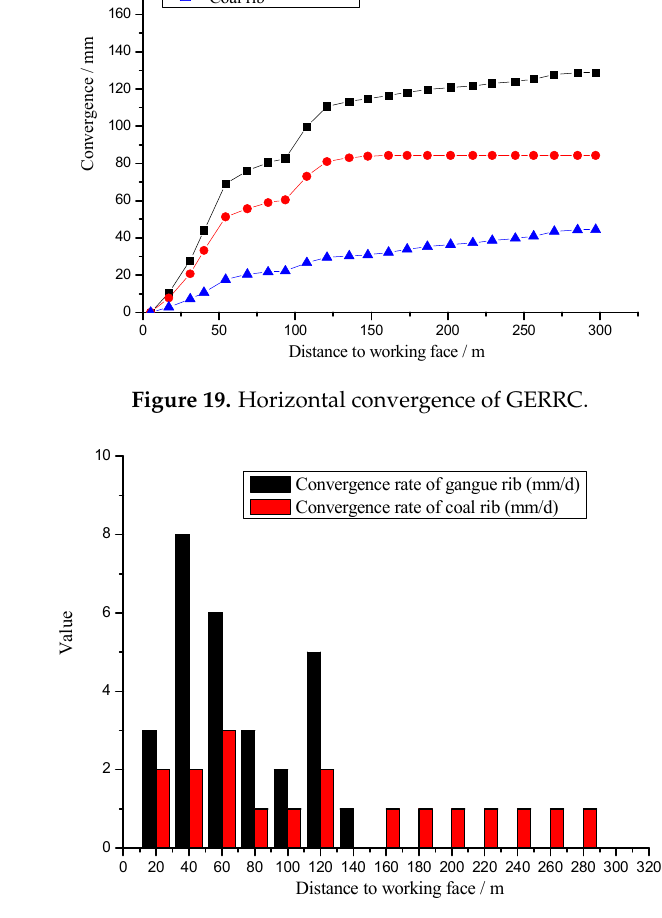
Figure 20. Horizontal convergence rate of GERRC.